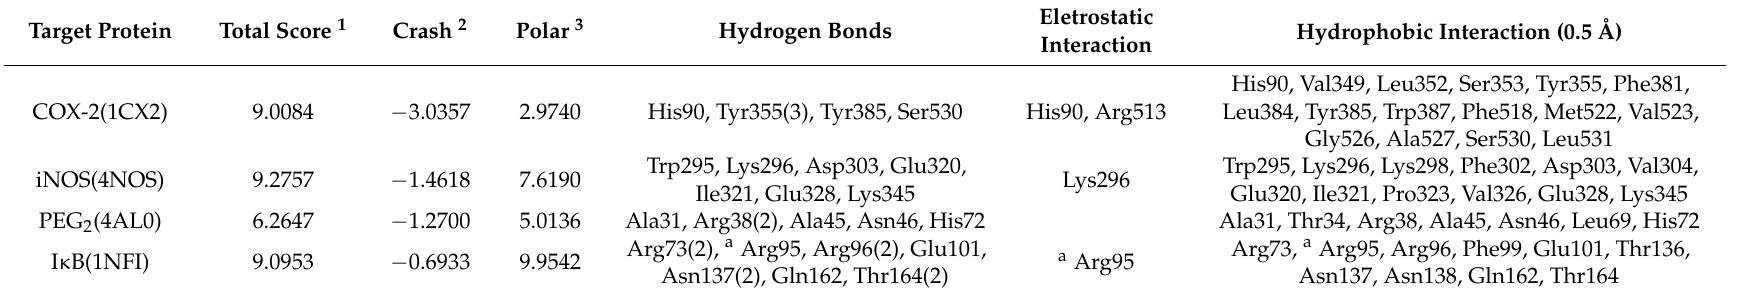
Table 1. Virtual binding score values and interaction between the ligand and amino acid residues in scandoside protein–ligand